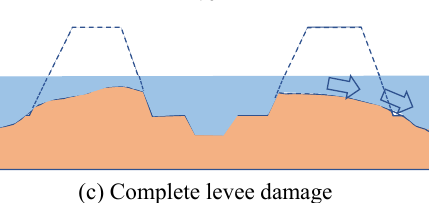
Figure 18. Breaching mechanism of the upstream levee location: ( a ) River water level rise, ( b ) Par- tial levee damage due to overflow from river, ( c ) Complete levee damage.